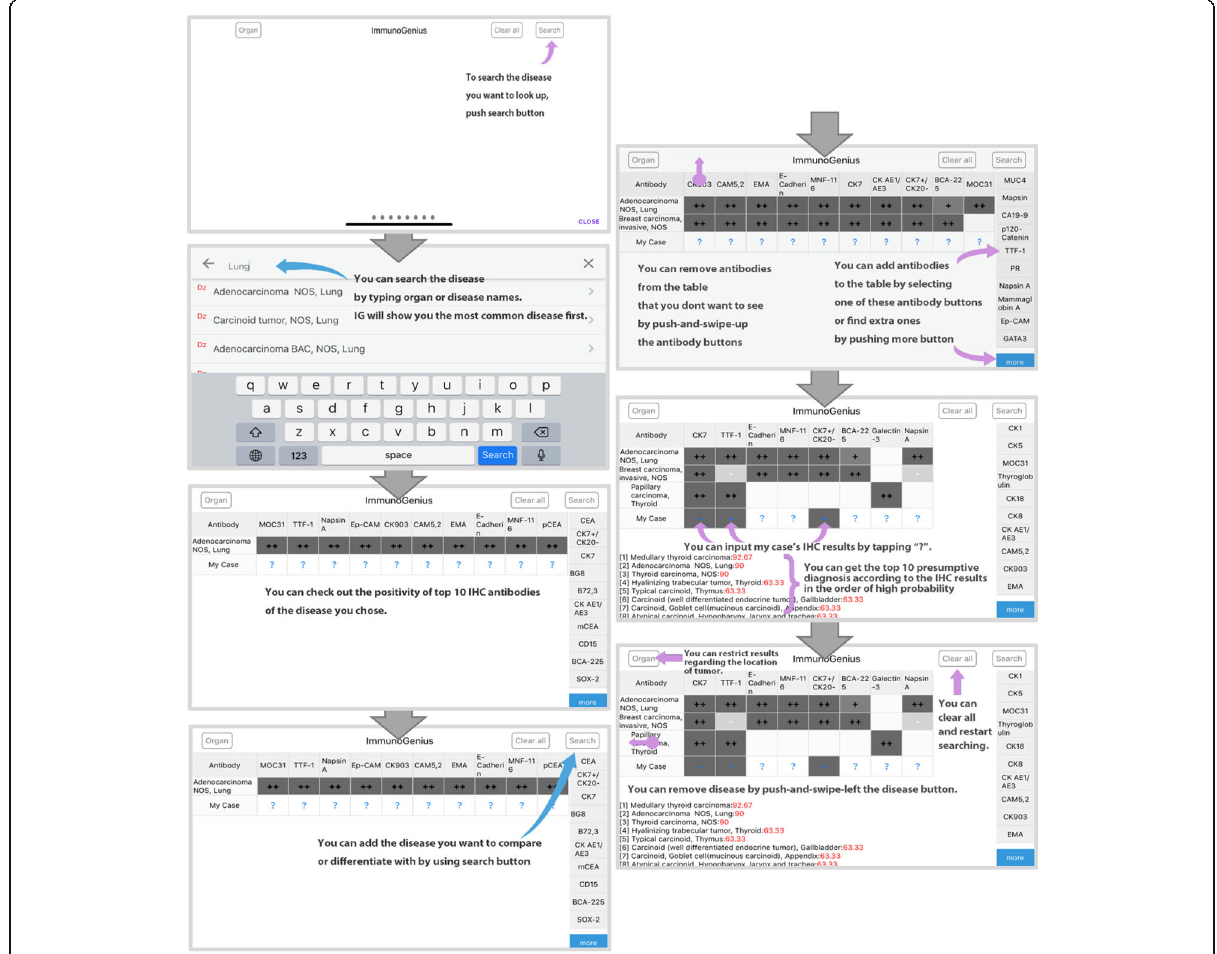
Fig. 4 Exemplary flowchart for